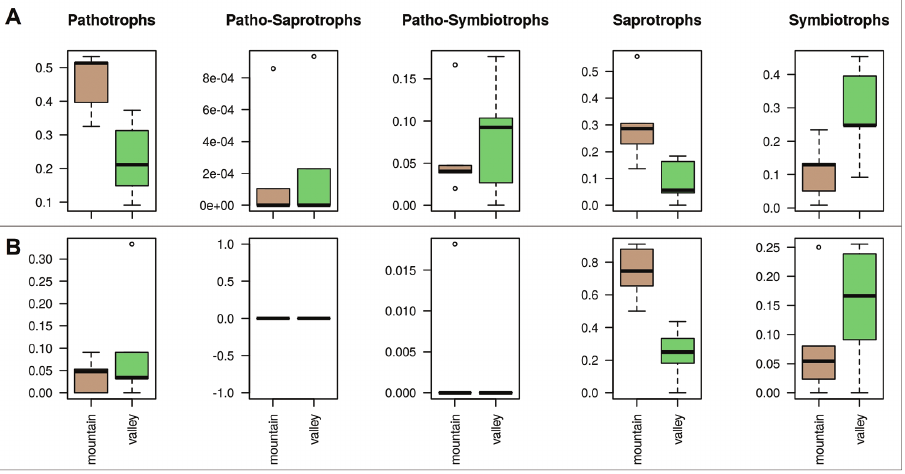
Figure 5. Relative abundance distribution of fungal leaf-inhabiting endophytes of beech among the five main trophic guilds as revealed by analysis with FUNGuild (Nguyen et al. 2016). A compares the two localities for each trophic guild on the basis of Illumina data B compares the two localities for each trophic guild on the basis of cultivation